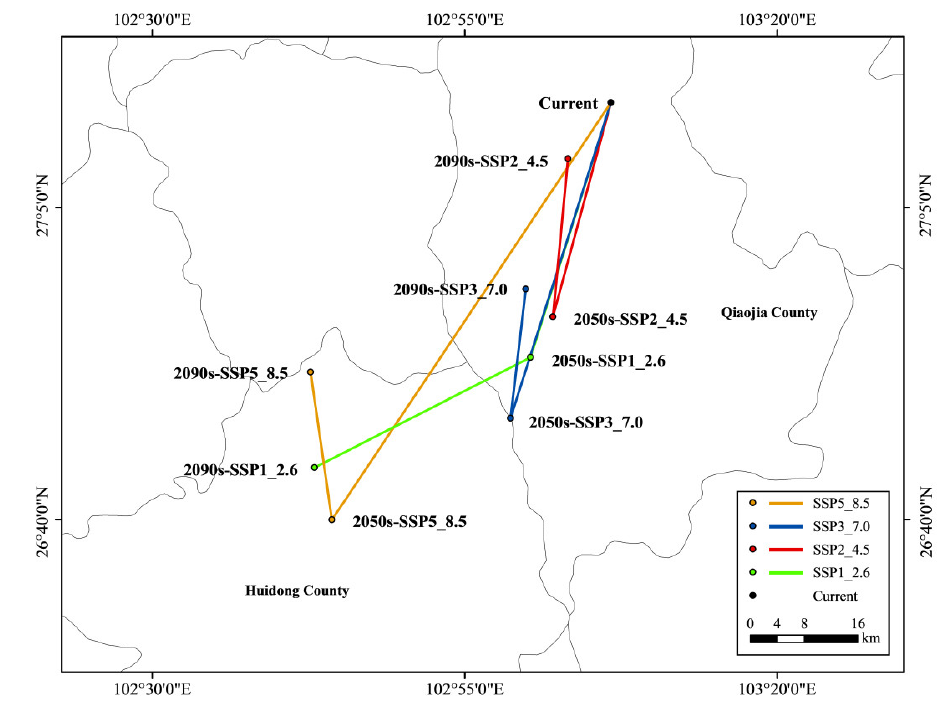
Figure 7. Shift in the centroids of highly suitable habitats of S. delavayi under four future climate scenarios.